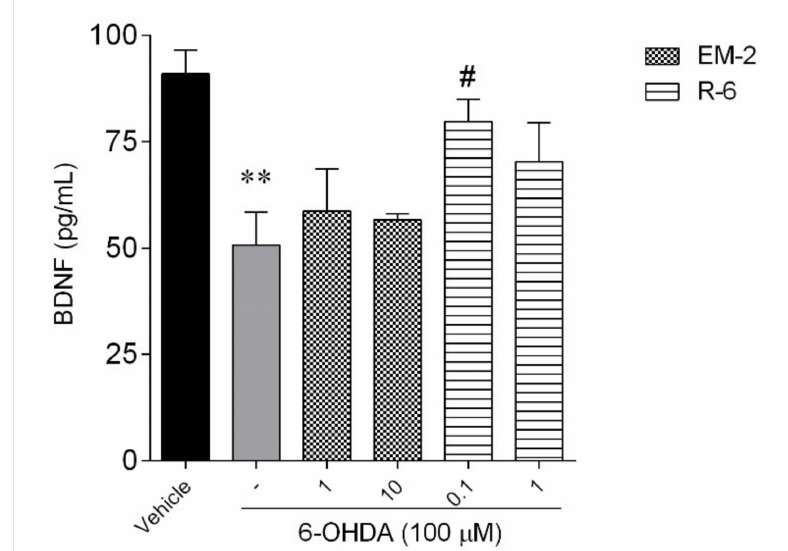
Figure 10. BDNF protein levels in the culture supernatant from SH-SY5Y cells treated by 6-OHDA (100 µ M) and EM-2 (1 and 10 µ M) or R-6 (0.1 and 1 µ M). The values in each column represent the mean ± standard error of the mean (SEM) of 3 independent experiments. Symbols represent significant differences (ANOVA, Dunnett’s test): ** p < 0.01 when compared to vehicle and # p < 0.05 when compared to 6-OHDA. (-)